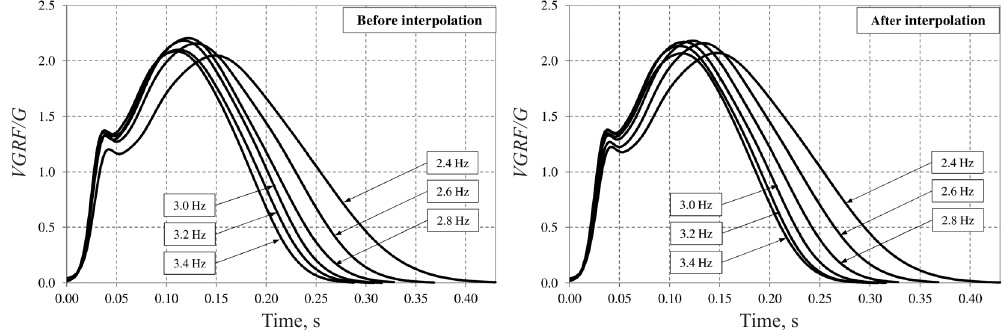
Figure 14. Collection of the VGRF / G templates in frequency range f r = 2.4–3.4 Hz before and after interpolation of the parameters of the Gaussian